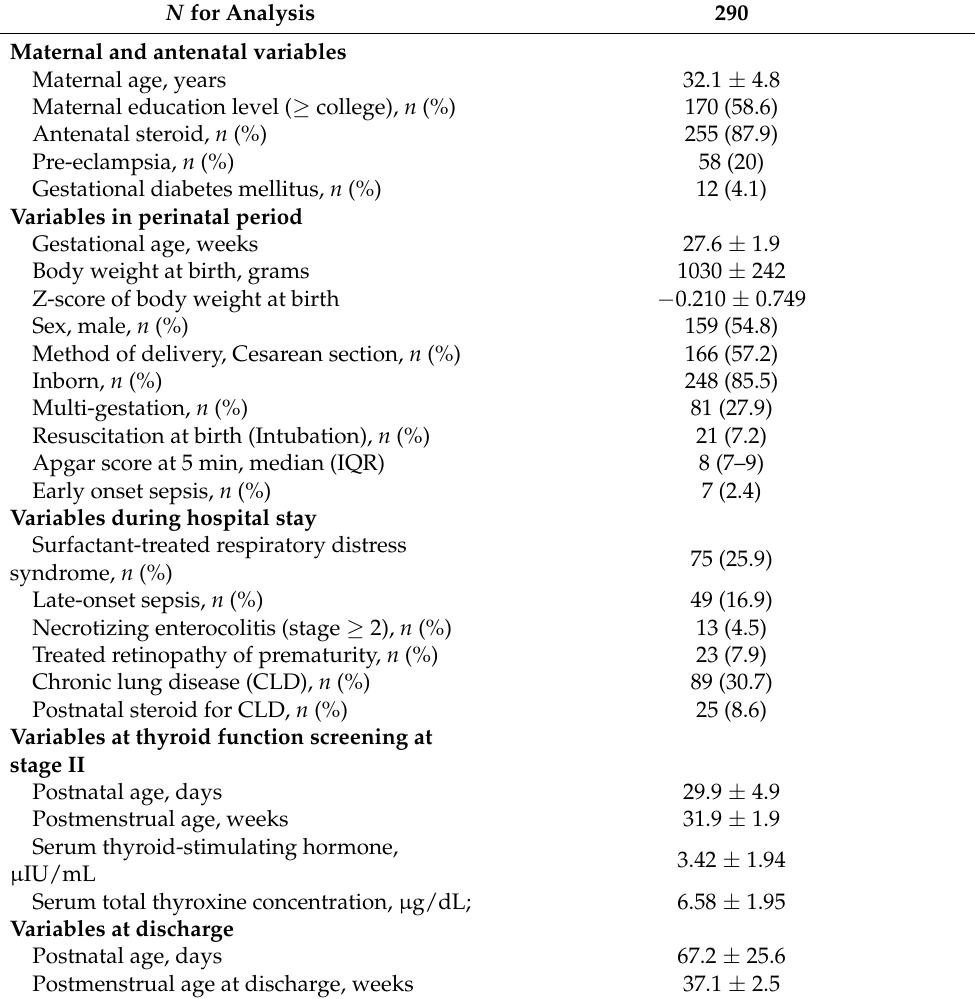
Table 1. Background clinical characteristics of the study